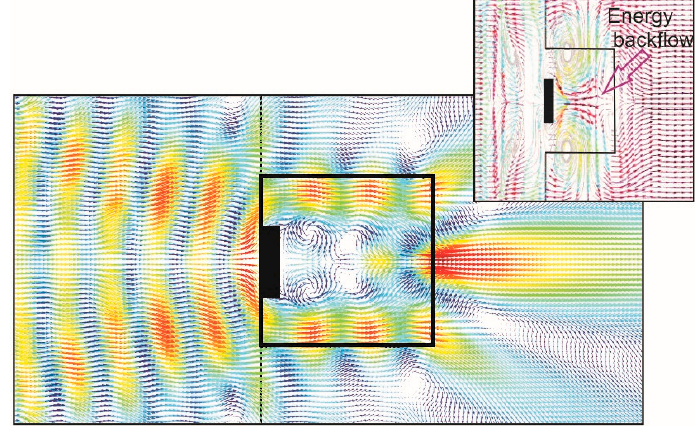
Figure 2. Poynting vector distribution and optical vortices in the phase step of mesoscale apodized diffraction grating. In the inset is the vortex structure of the optical flow for the optimized mask which blocks the photonic jet formation.